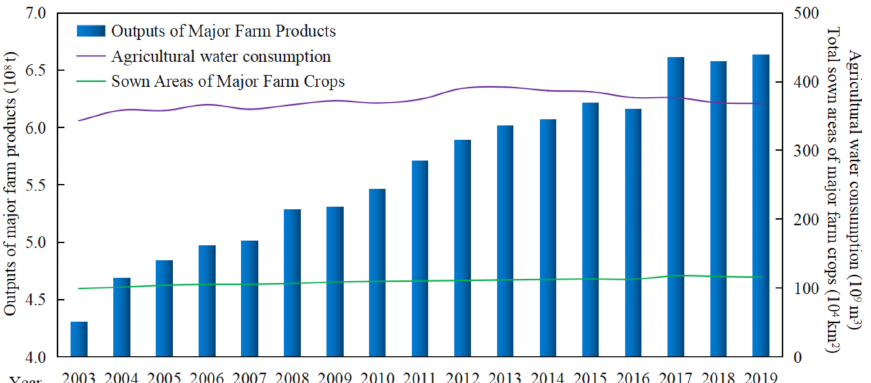
Figure 2. Changes of grain yield and cropland and water resources consumption in China from 2003 to 2019. Sown area of major farm crops (rice, wheat, corn, beans and tubers) and its outputs data were obtained from the China Statistical Yearbook (2004–2020). Agricultural water consumption data were obtained from the China Water Resources Bulletin